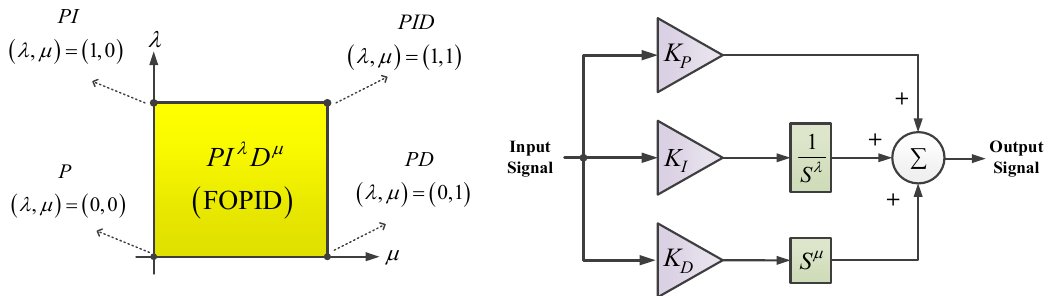
Figure 4. The general structure of the proposed fractional order proportional-integral-differential (FOPID) controller.